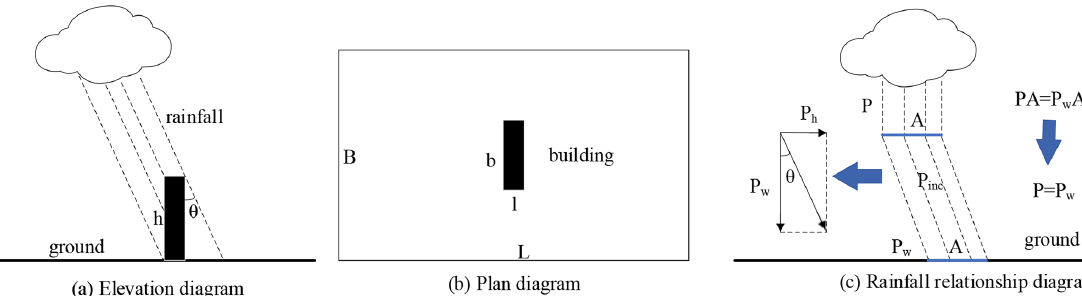
Figure 1. Sketch of the urban high-rise building